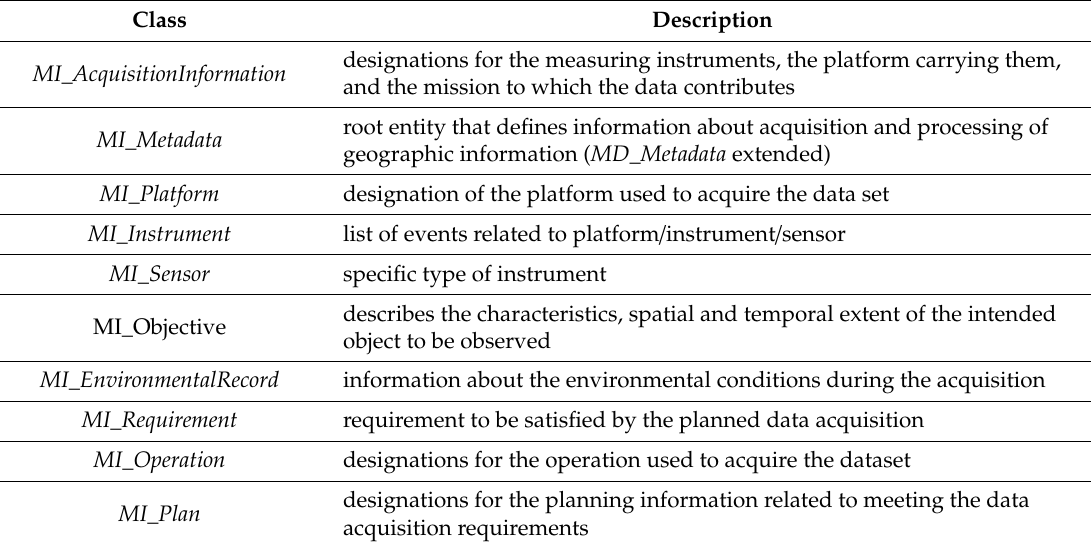
Figure 4. ISO 19115-2 structure for acquisition and processing. Table 4. Summary of the classes of ISO 19115-2 structure for acquisition and processing. Class